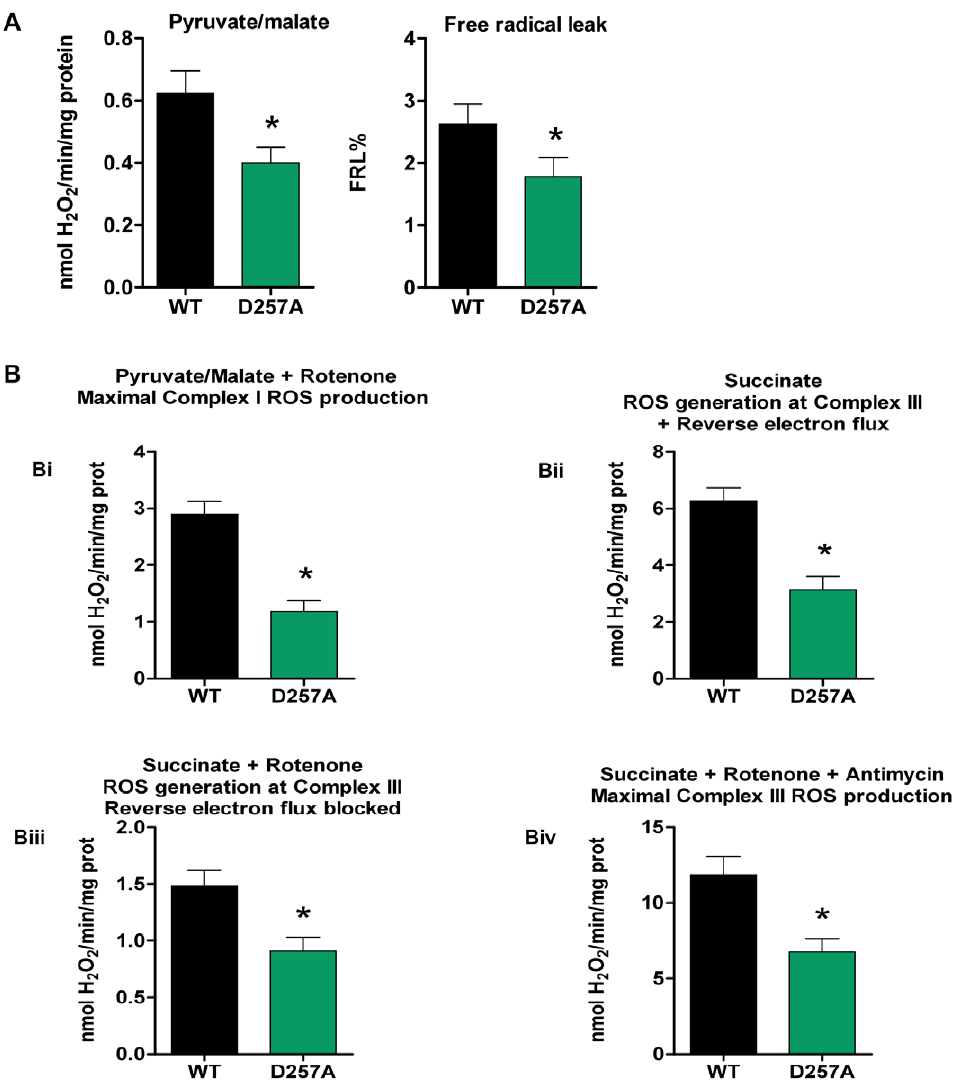
Figure 8. D257A mitochondria produce fewer ROS in both main ROS generators (Complex I and Complex III). (A) We measured H 2 O 2 production using a sensitive fluorometric assay. Skeletal muscle mitochondria were obtained from 11-mo old, WT and D257A mice (n=11 per group) and supplemented with pyruvate/malate as substrate for oxidative phosphorylation. Pyruvate/malate was used to study complex I ROS production (under near physiological conditions) which also represents total basal mitochondrial ROS production. Free radical leak percent (FRL%), an index of mitochondrial efficiency, was calculated by dividing the H 2 O 2 value by twice the state 4 respiration value and the result was multiplied by 100 to give a % final value. Mean values 6 SEM are shown. *p , 0.05 (B) We used inhibitors of the ETC in order to study maximum rates of H 2 O 2 production from complexes I and III, since they represent the main sites of ROS generation within the mitochondria (n=11 per group). For complex I maximum rate (panel B i ) we used rotenone added to pyruvate/malate-supplemented mitochondria. For complex III maximum rate (panel B iv ) we used antimycin A plus rotenone, added to succinate- supplemented mitochondria. We also used mitochondria supplemented with succinate alone in order to study complex III ROS production under near physiological conditions (panel B ii ). In addition, some of the assays with succinate as substrate were performed in the presence of rotenone (panel B iii ), in order to avoid the backwards flow of electrons to Complex I. Mean values 6 SEM are shown. *p #